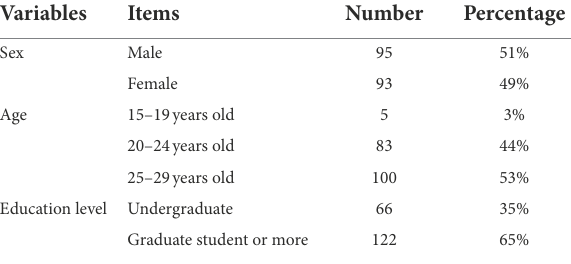
TABLE 2 Demographic composition of the participants (Study 2).